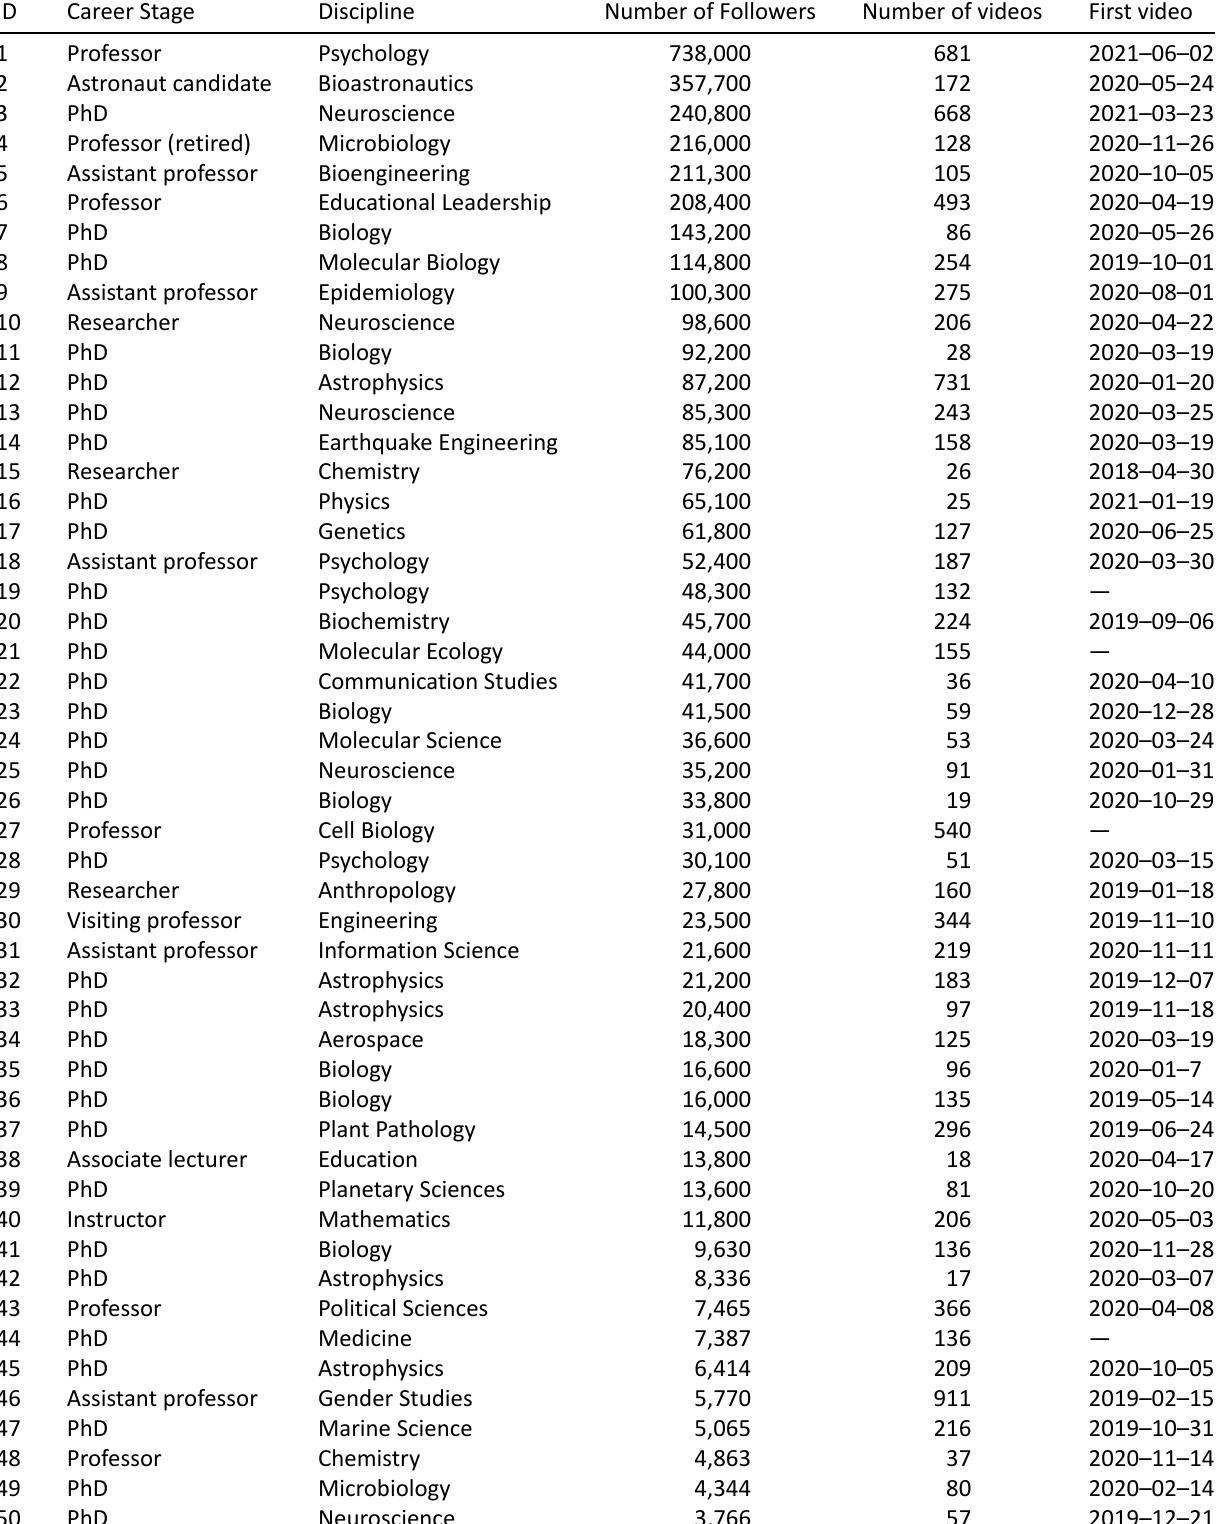
Table 1. Sample: Selected accounts of women scientists on